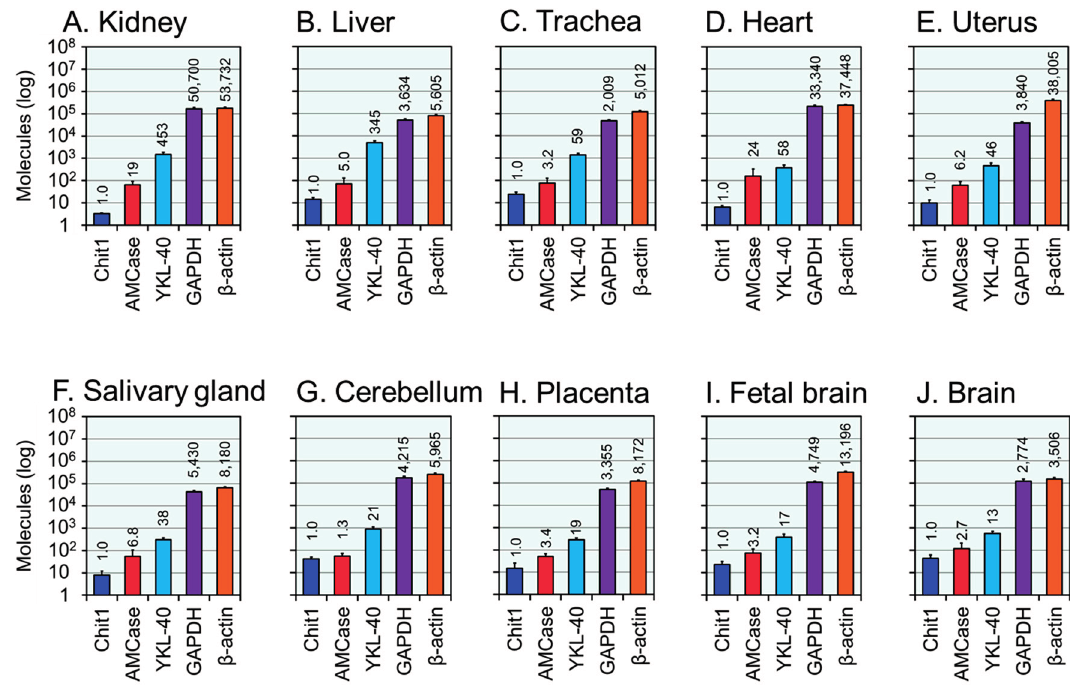
Figure 4. Human tissues with expression levels of YKL-40 more than 10-times higher than those of Chit1. Expression analysis of five genes in kidney ( A ); liver ( B ); trachea ( C ); heart ( D ); uterus ( E ); salivary gland ( F ); cerebellum ( G ); placenta ( H ); fetal liver ( I ) and whole brain ( J ) tissues using qPCR. All values are expressed as number of molecules per 10 ng of total RNA in y -axis. Logarithm of each value is shown. The expression level of Chit1 was set to 1.0; the values above bars indicate the relative expression levels compared to Chit1. Human tissue samples were pooled from 1–64 Caucasians: kidney, n = 1; liver, n = 1; trachea, n = 22; heart, n = 3; uterus, n = 8; salivary gland, n = 24; cerebellum, n =